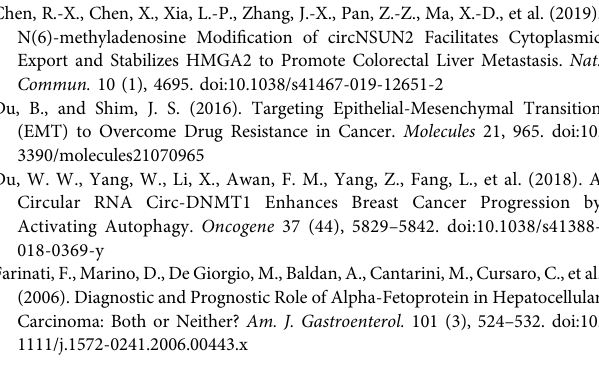
Supplementary Figure S1 | The transfection ef fi ciency of circFGGY plasmids and ASO. (A) MHCC97H cells transfected with the circFGGY overexpression vector or circFGGY NC-vector and HepG2 cells transfected with ASO-NC were observed by fl uorescence microscope. Scale bar, 50 µm. (B) qRT-PCR validated the upregulation of circFGGY in MHCC97H cells transfected with circFGGY overexpression vector and downregulation in HepG2 cells transfected with ASO- circFGGY ( n = 3). (C) Statistical diagram of Figure 3E ( n = 3). (D) Statistical diagram of Figure 3J ( n = 5). Data were shown as mean ± SD. *: p < 0.05, **: p < 0.01 in independent Student ’ s t test. Supplementary Figure S2 | The RNA expression of putative targets after regulating circFGGY. (A) qRT-PCR detected the expression of smad2, smad3, smad4, smad6 and FGGY in MHCC97H cells transfected with circFGGY overexpression vector ( n = 4). (B) Statistical diagram of Figure 4B . (C) qRT- PCR detected the expression of miR-545-3p in MHCC97H cells transfected with circFGGY overexpression vector and in HepG2 cells transfected with ASO- circFGGY ( n = 3). (D) qRT-PCR detected the expression of circFGGY in HepG2 cells transfected with miR-545-3p mimics or inhibitors ( n = 3). (E) Statistical diagram of Figure 7E ( n = 5). Data are presented as mean ± SD. P values were calculated by unpaired independent Student ’ s t test (A – D) and